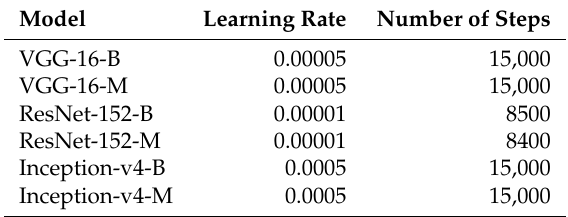
Table 4. Hyperparameter values. We used early stopping to alleviate